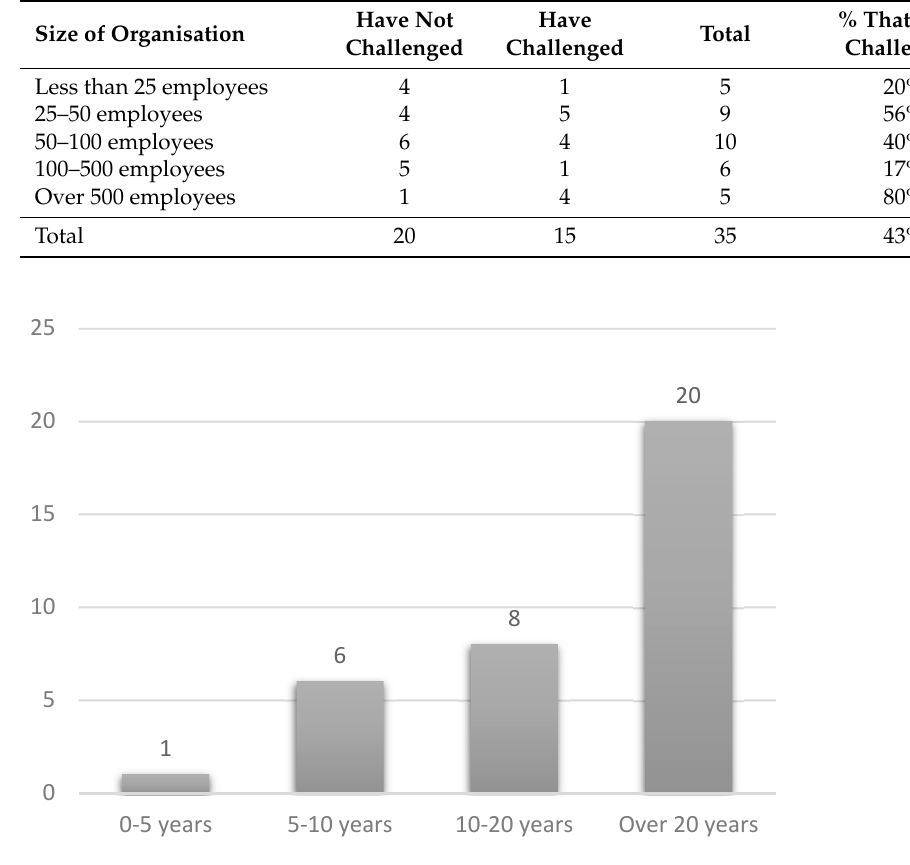
Figure 9. Respondents by number of years’ experience in their role.